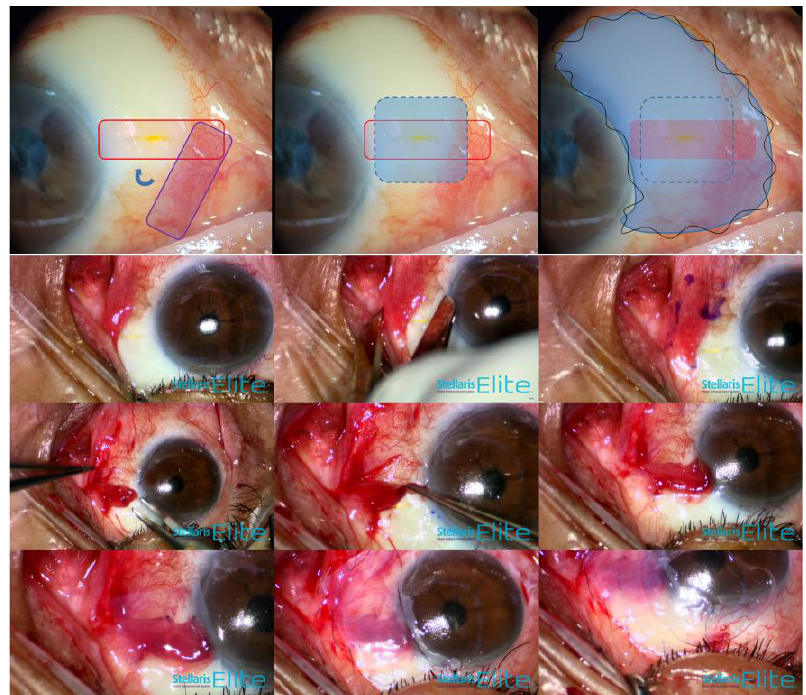
Figure 4. Schematic plan for rotational conjunctival flap and the amniotic membrane transplantation using fibrin glue and anchoring suture (purple: harvested donor conjunctiva; red: rotational conjunctival flap; light blue dotted line: complementary amniotic membrane graft using fibrin glue; blue line: temporary amniotic membrane transplantation using 10-0 nylon continuous locking suture (black line).